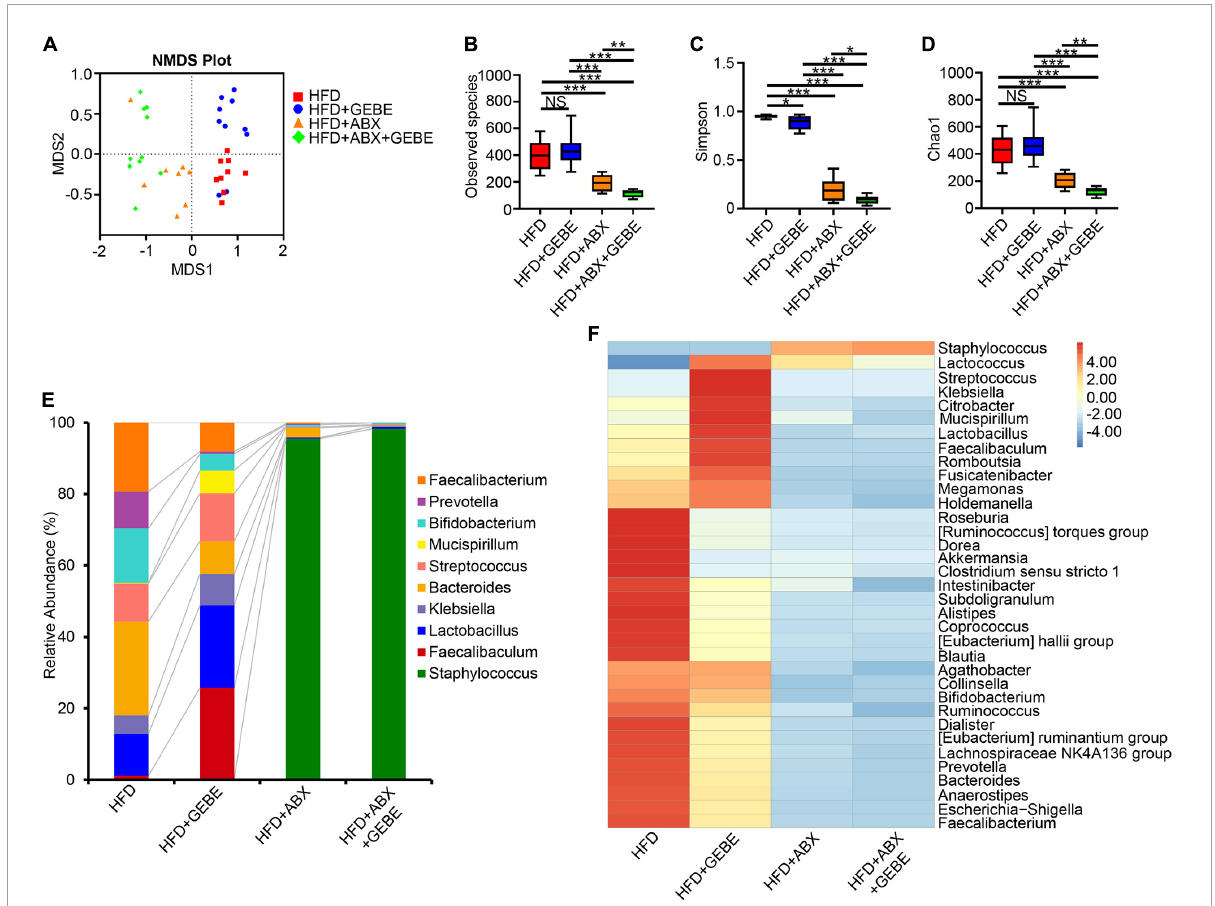
FIGURE4 ABX treatment suppressed the intestinal microbiota in mice ( n = 8–10). (A) Non-metric multi-dimensional scaling (NMDS) analysis. (B–D) The alpha diversity boxplots were measured using Observed species (B) , Chao1 (C), and Shannon (D) diversity indexes. (E) The relative abundance of bacteria at genus levels. (F) Heatmap of gut microbiota at the genus level. * p < 0.05, ** p < 0.01, and *** p < 0.001. NS, not statistically significant. The results are presented as mean ± SEM. HFD, High-fat diet; HFD + GEBE, High-fat diet with GEBE; HFD + ABX, High-fat diet and water with combined antibiotics; HFD + ABX + GEBE, High-fat diet with GEBE, and water with combined